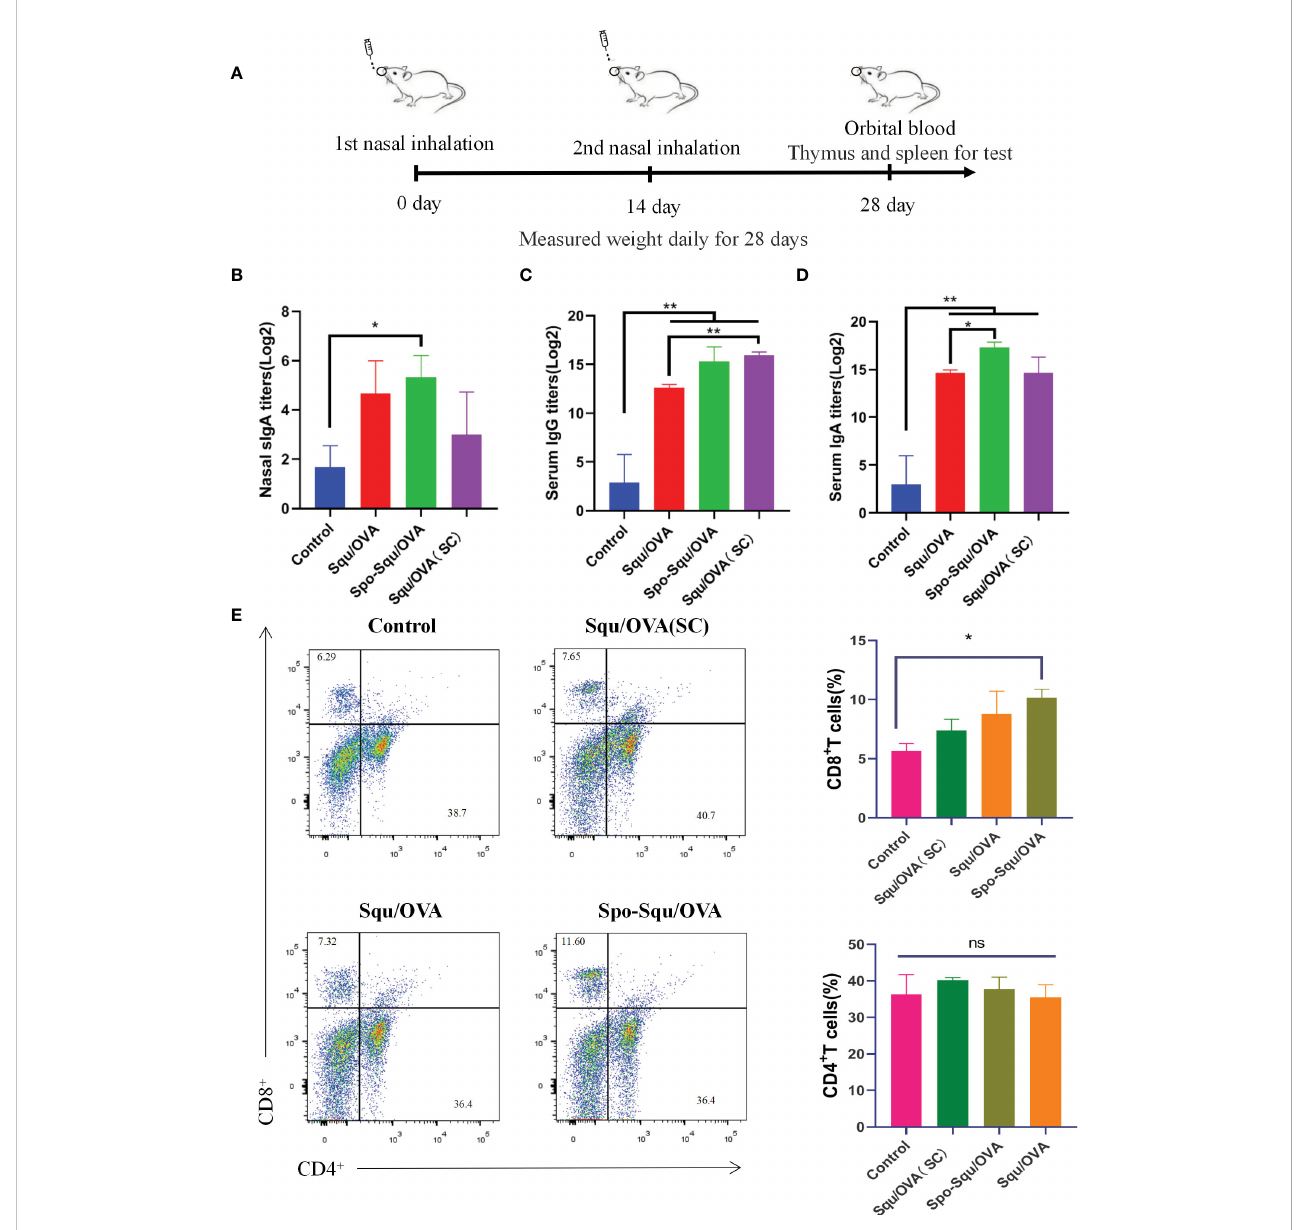
FIGURE 3 Spo-Squ /OVA enhanced systemic and mucosal immun e responses after intran asal vaccination. BALB/c mice were immunized intranasally wi th 25 µg of OVA or mixed with 25 µg of adjuvant and boosted 2 weeks later with the same formulations. Control groups re present samples coll ected from mice immuni zed with PBS witho ut antigens. (A) Timeline representation of experimental porceduures. (B) Mucosal slgA titers in nasal wash. (C) IgG and (D) IgA titers in serum. (E) The percentage of CD8+ T and CD4+ T cells in the spleens after ex vivo stimulation with the OVA (5 µg/ mL) for 24 hours. Signi fi cant differences were determined by double-tail t-test. Values were repotied as mean ± SEM (n=3). The asterisks indicate signi fi cant differences ("*" P<0.05, "**" P<0.01, "ns"